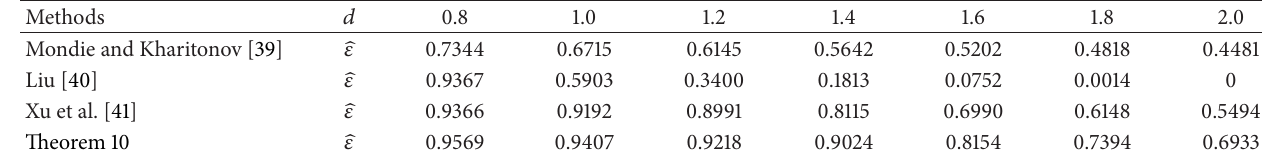
Table 1: Maximum exponential decay rate ̂𝜀 with different parameter 𝑑 .